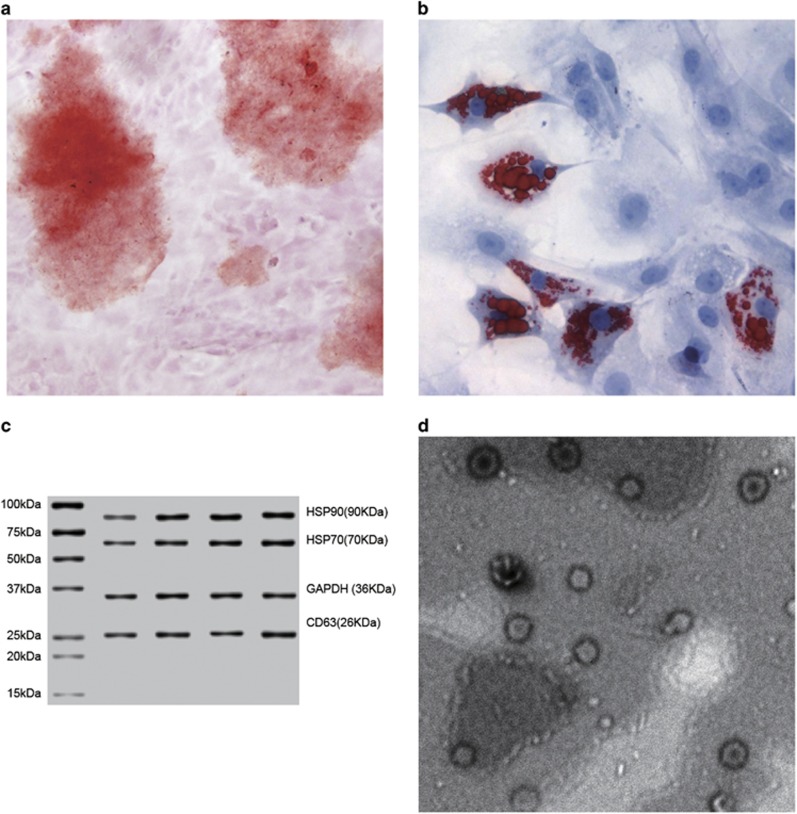
Differentiation abilities of ADMSCs and the identification of exosomes. Note: (a) ADMSCs stained with alizarin red after the osteoinductive differentiation; (b) ADMSCs stained with Oil Red O after the adipogenic differentiation; (c) Exosome protein expression detected by western blotting; (d) Exosome structure under the transmission electron microscopy (50 000 ×); ADMSC, adipose-derived mesenchymal stem cells.